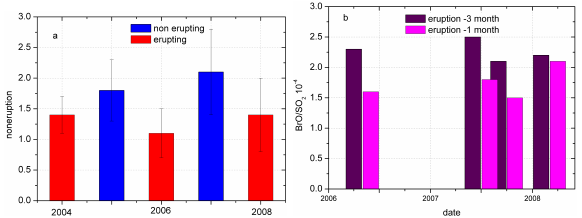
Fig. 6. (a) Measurement data were averaged for eruptive and non- eruptive periods. The BrO/SO 2 mean is plotted as function of time. Eruptive data are presented as red columns and non-eruptive data as blue columns. Although this is only a small statistical approach, it demonstrates that during eruptions lower BrO/SO 2 ratios have been measured. (b) Additionally to (a) mean BrO/SO 2 values of the third month before the eruption (violet columns) and mean BrO/SO 2 values of the month just before the eruption (magenta columns) have been compared for the four eruptive events described in the text. Clear enhanced mean BrO/SO 2 values are determined for the third month before the eruption and smaller mean BrO/SO 2 values the month before the eruption (see also Table